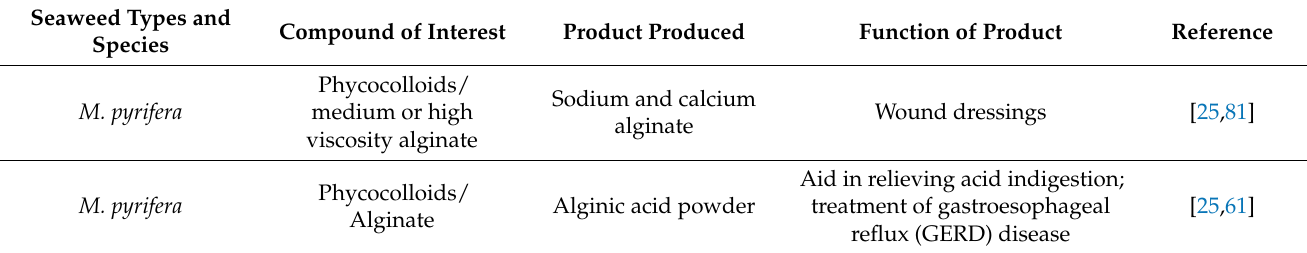
Table 2. Current commercial pharmaceutical products from Macrocystis pyrifera and Laminaria spp . Seaweed Types